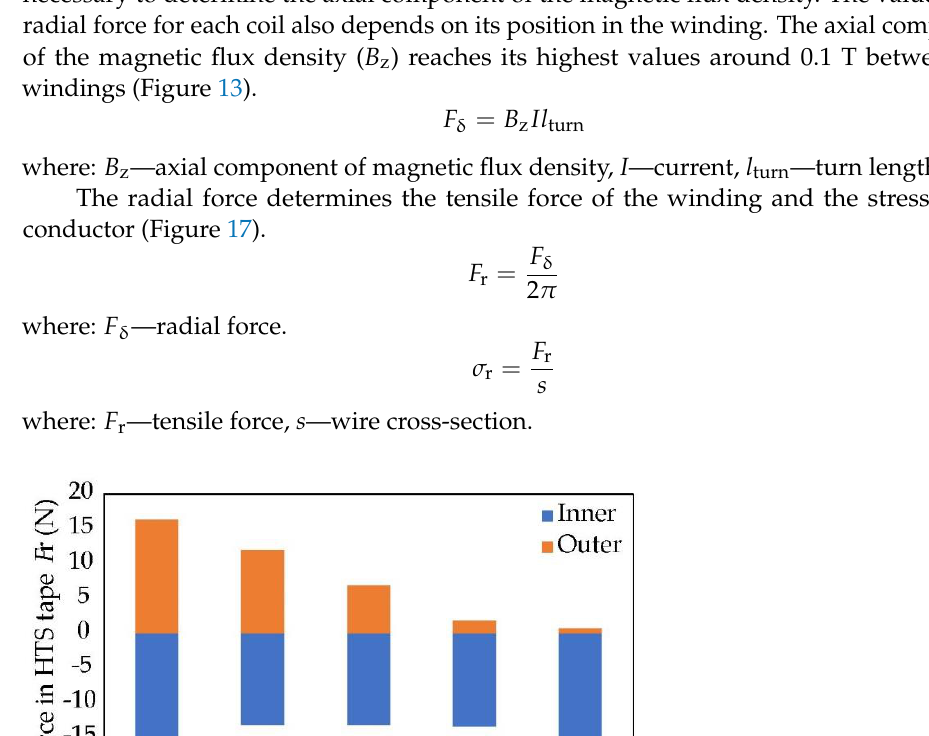
Figure 18. Stress in HTS tape during short-circuit.